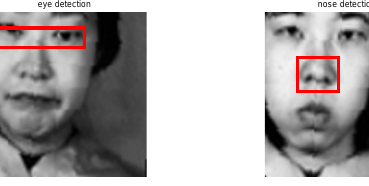
Figure 7. The part of some important components of the face